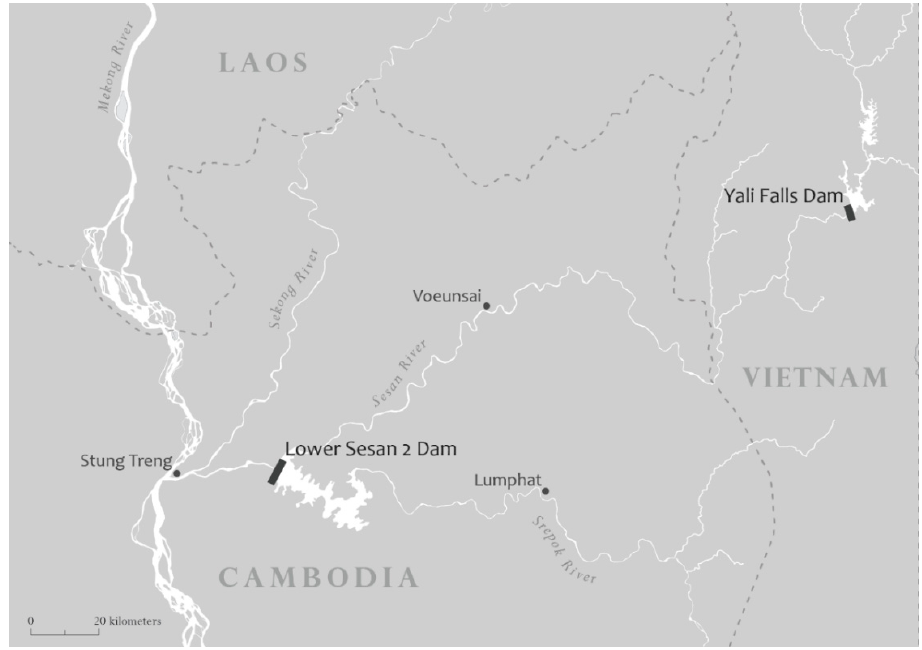
Figure 1. The Sesan River Basin, including the Yali Falls Dam and the Lower Sesan 2 Dam, northeastern Cambodia and the Central Highlands of Vietnam.